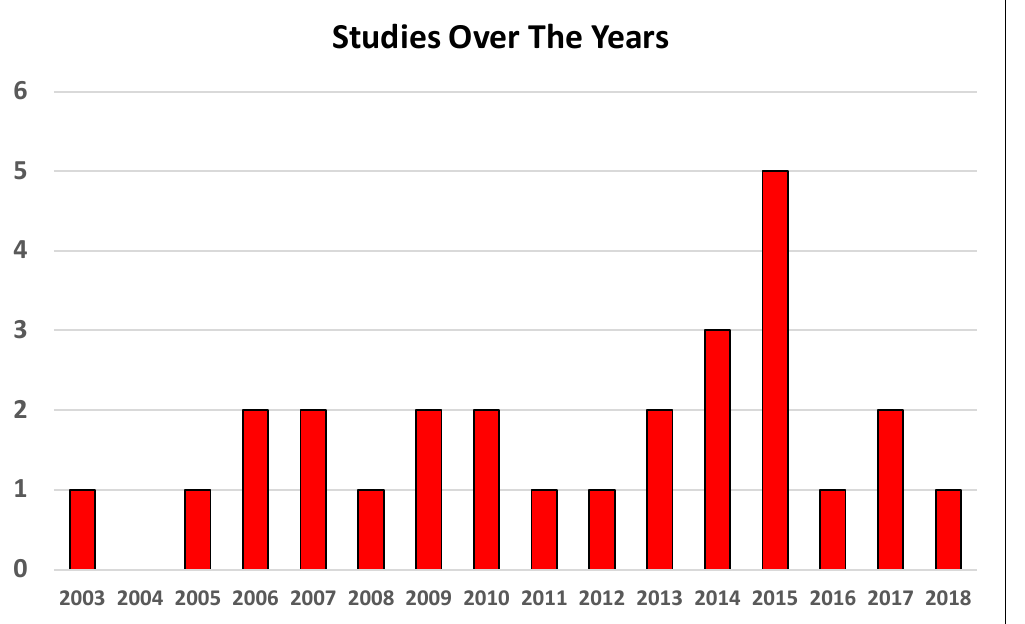
Figure 1. Temporal trend of the published papers about the influence of HA on balance.